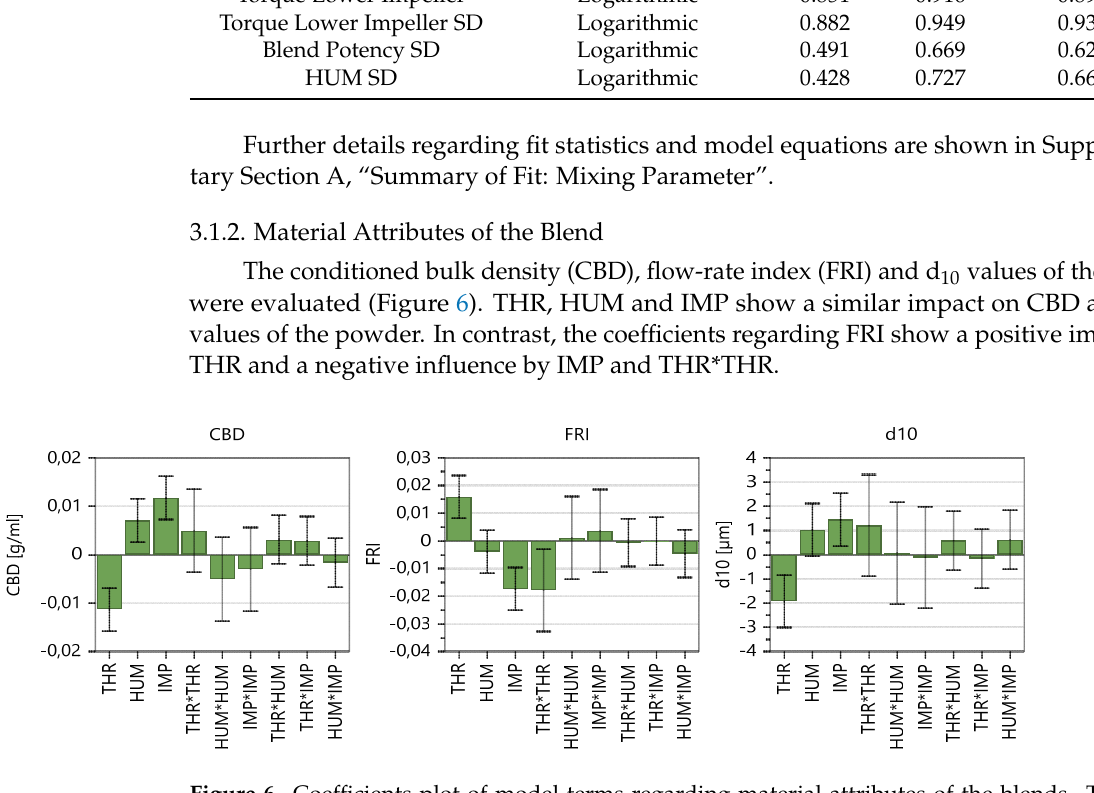
Table 7. Overview of fit statistics regarding material attributes of the blend.